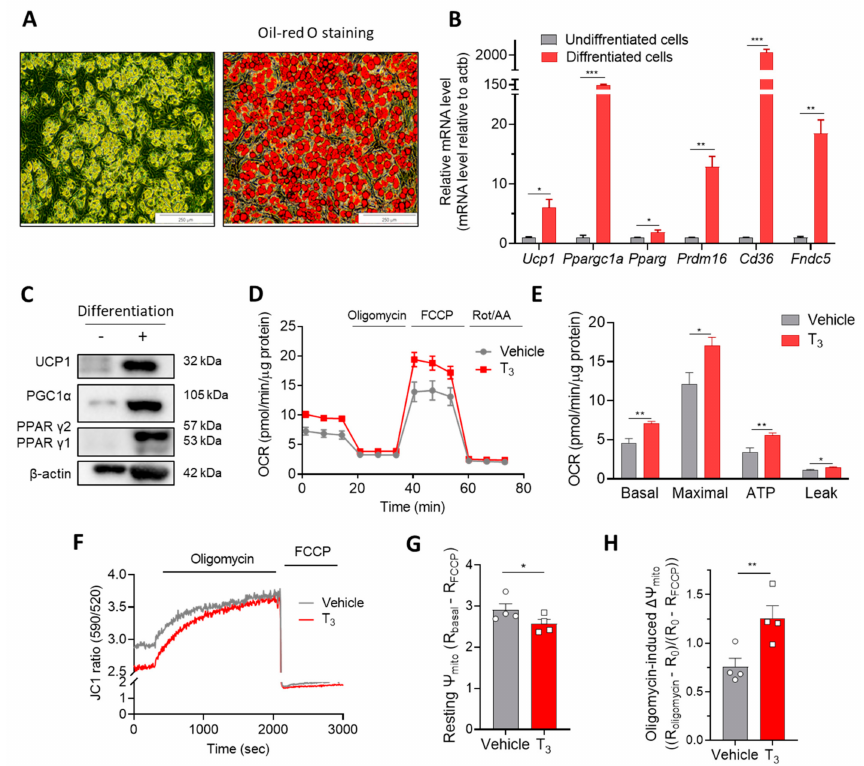
Figure 1. T 3 induces mitochondrial activation in brown adipocytes within 30 min. ( A ) Oil red O staining of differentiated primary mouse brown adipocytes. ( B ) Relative mRNA levels of Ucp1, Ppargc1a, Pparg, Cd36, Fndc5 (normalized to Actb ) ( n = 3) and ( C ) western blot of UCP1, PGC1 α and PPAR γ of undifferentiated and differentiated primary brown adipocytes. ( D ) OCR measurement in primary brown adipocytes with 10 nM T 3 for 30 min. ( E ) Quantitative analysis of basal respiration, maximal respiration, ATP production, and proton leak ( n = 4). ( F ) Mitochondrial membrane potential ( Ψ m) measurement with JC1 dye on immortalized brown adipocytes with 10 nM T 3 treatment for 30 min. ( G ) Quantitative analysis of resting Ψ m and ( H ) Oligomycin-induced hyperpolarization ( ∆Ψ m, n = 4). Data are presented as mean ± SEM. * p ≤ 0.05, ** p ≤ 0.01, *** p <